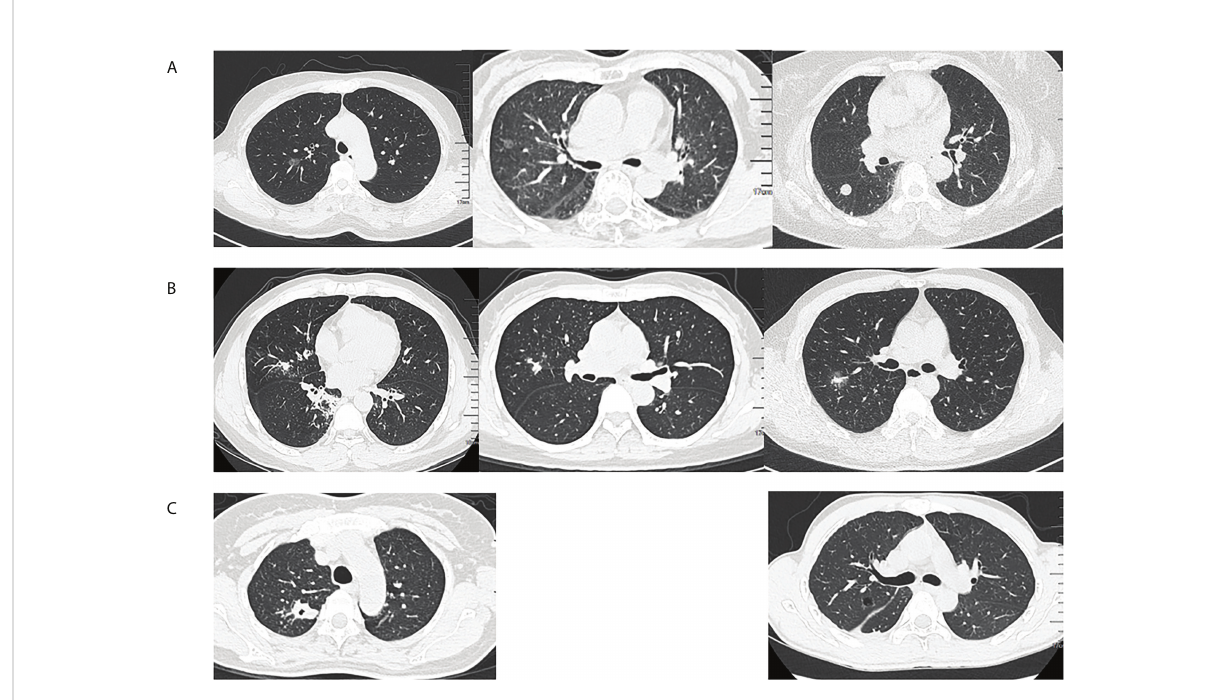
FIGURE 3 Classi fi cation of chest computed tomography (CT) in non-tuberculosis patients. (A) Nodular type: ground glass nodules or solid nodules, (B) Pneumonia type: focal or patchy mixed density shadow, and (C) Mixed type: other manifestations such as cavity, cystic or pleural